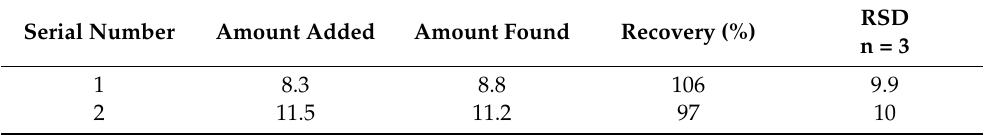
Table 6. Percent recovery and RSD (%) of EFV on GCE/TiO 2 -NPs-nafion in Cipla EFV sample.